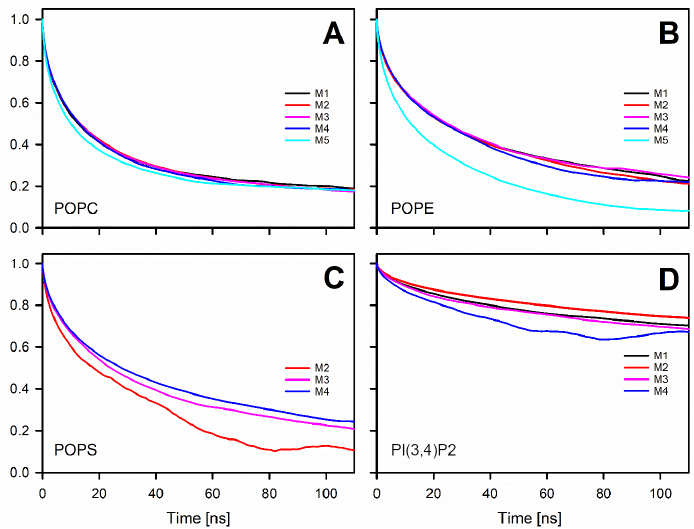
Figure 4. Rotational autocorrelation functions of the lipid headgroups in membrane models for each lipid species: ( A ) POPC, ( B ) POPE, ( C ) POPS, and ( D ) PI(3,4)P2. (Figure 1) The membrane models (Models #1-#5 or M1-M5, Table 1) are shown with distinct colored lines.